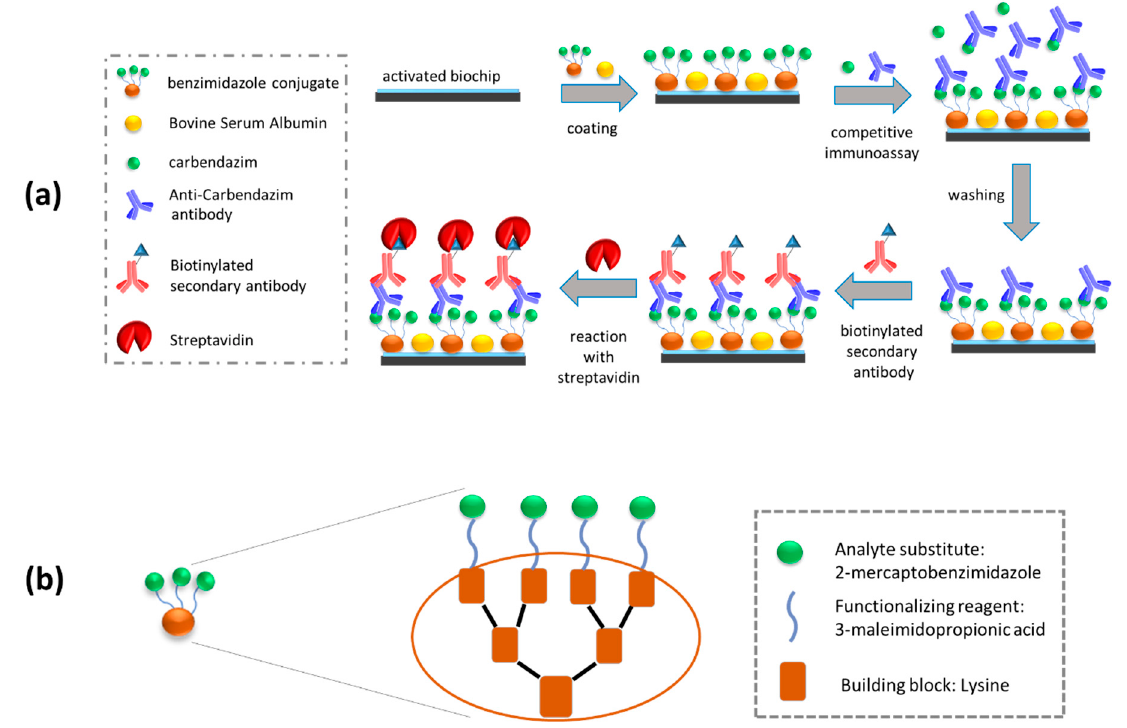
Figure 1. Schematic representation of ( a ) assay procedure for the detection of carbendazim with the WLRS sensor and ( b ) benzimidazole conjugate structure.